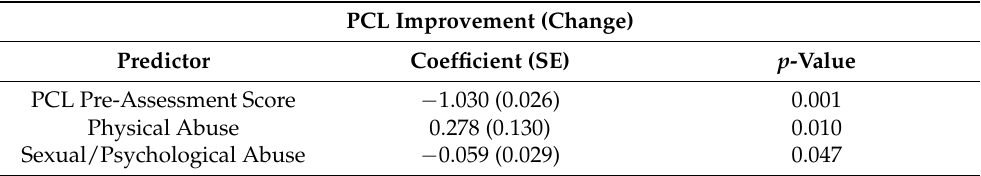
Table 3. Regression results for predicting PCL improvement (change) based on type of abuse.